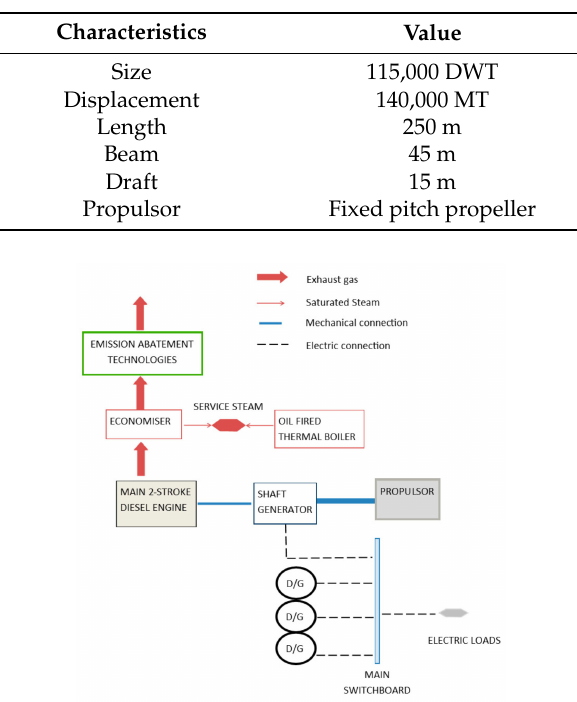
Table 1. Investigated tanker ship characteristics.